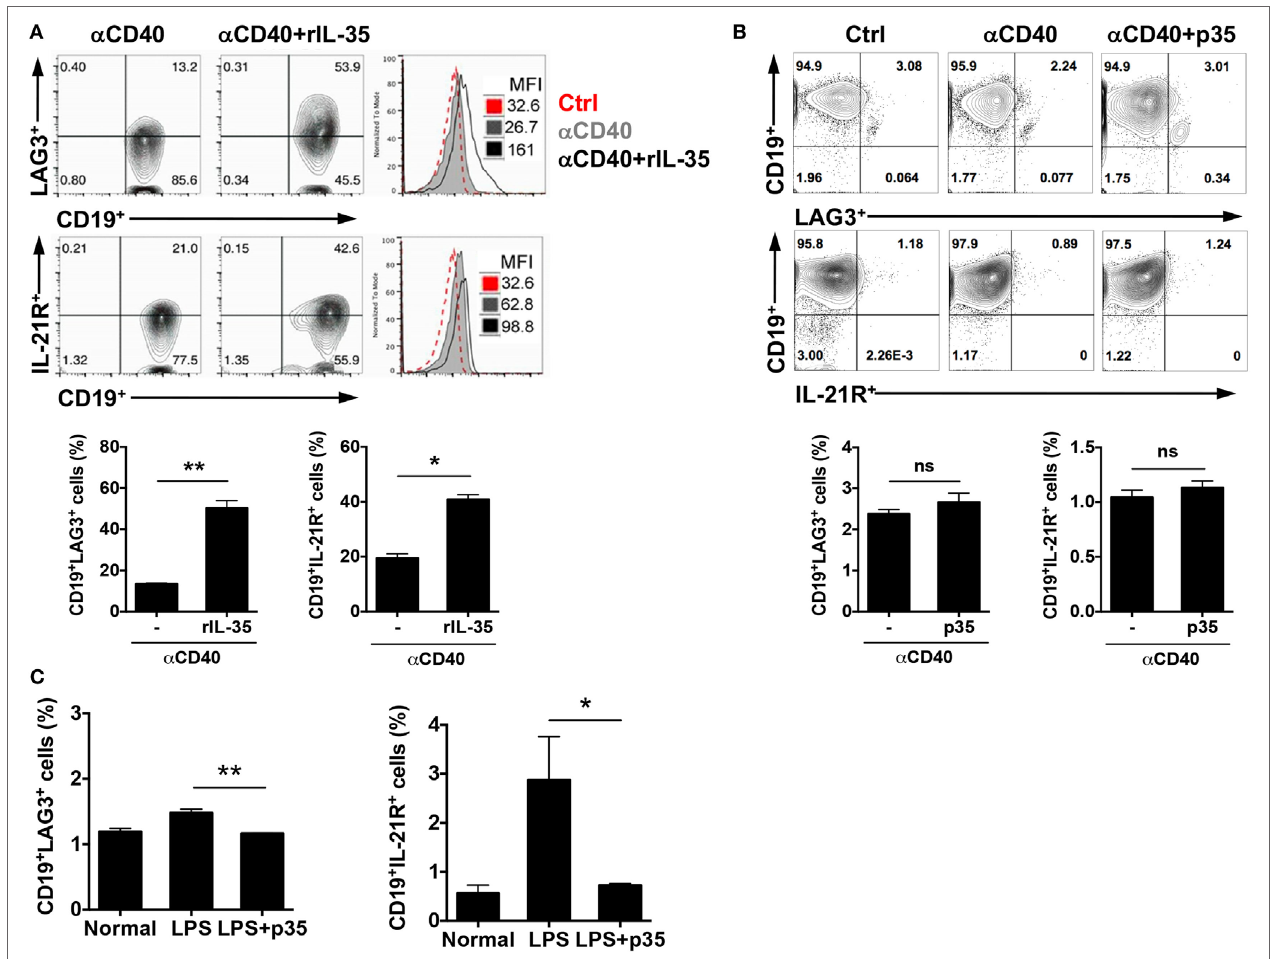
FigUre 5 | IL-35 but not IL-12p35 induces expansion of LAG3- and IL-21 receptor (IL-21R)-expressing B cells. (a) Sorted CD19 + B cells were cultured in the absence or presence of anti-CD40Ab (2 µg/ml) or anti-CD40 antibody (Ab) plus IL-35 (100 ng/ml) for 4 days. (B) Sorted CD19 + B cells were cultured in the absence or presence of anti-CD40Ab or anti-CD40 Ab plus p35 (100 ng/ml) for 4 days. The expression of LAG3 and IL-21R were analyzed with FACS. (c) Mice were injected with LPS (15 μ g/mouse) via i.p. After 96 h, we analyzed the expression of LAG3 or IL-21R by FACS. The data are presented as the mean ± SEM of four determinations. **** p < 0.0001; *** p < 0.001; ** p < 0.01; * p < 0.05. Data are representative of at least three independent